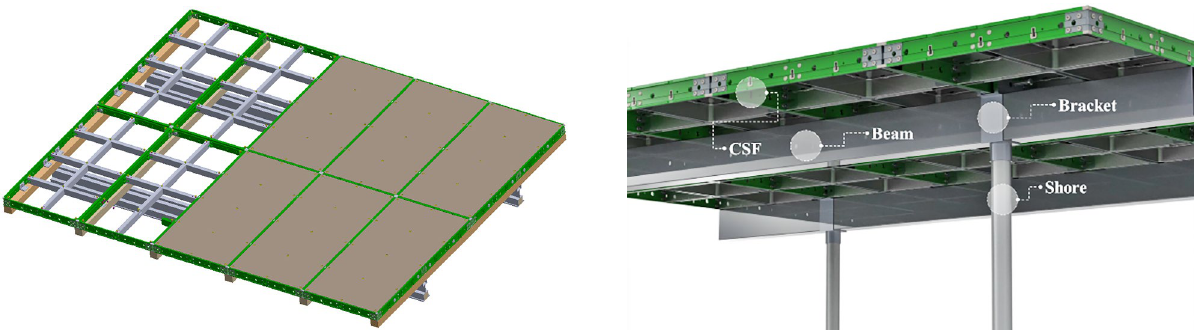
Figure 11. 3D drawing of CSF table form